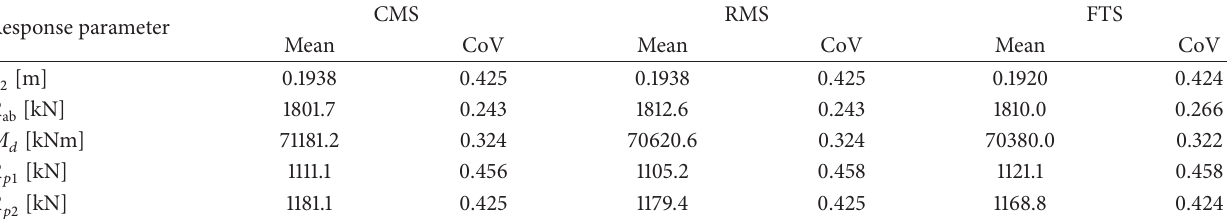
Table 5: Comparison of results (mean values and CoV of the response) according to the different analysis techniques. Response parameter